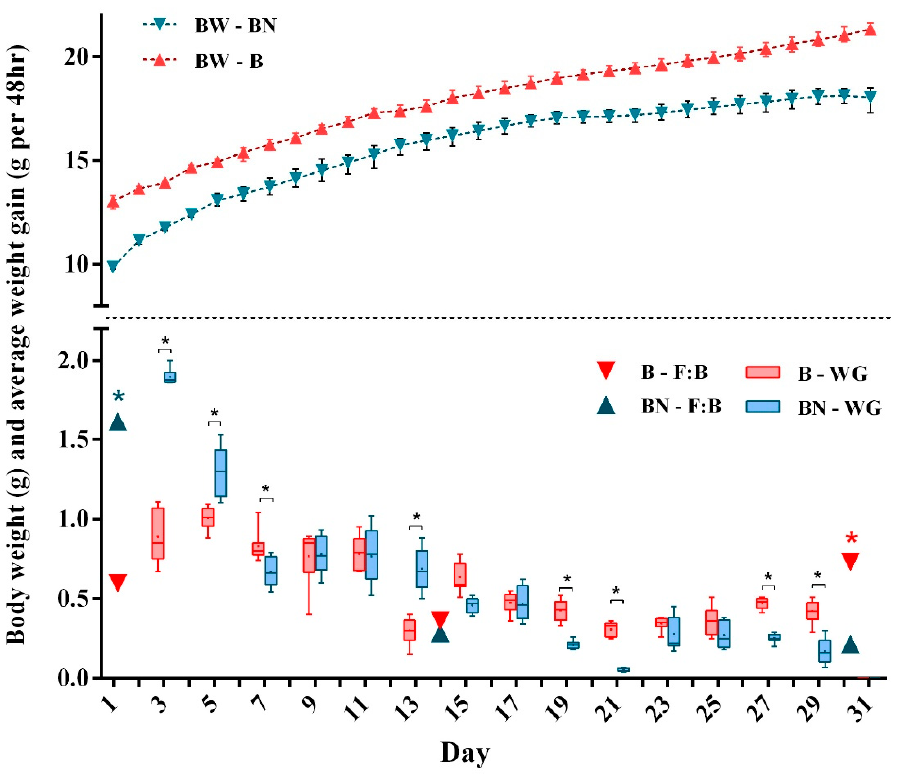
Figure 3. Body weight (BW), average body weight gain (BWG) and the Firmicutes:Bacteroidetes (F:B) ratio of normal and nude BALB/c pup mice. The asterisks show the significance determined by independent t-test ( p < 0.05).